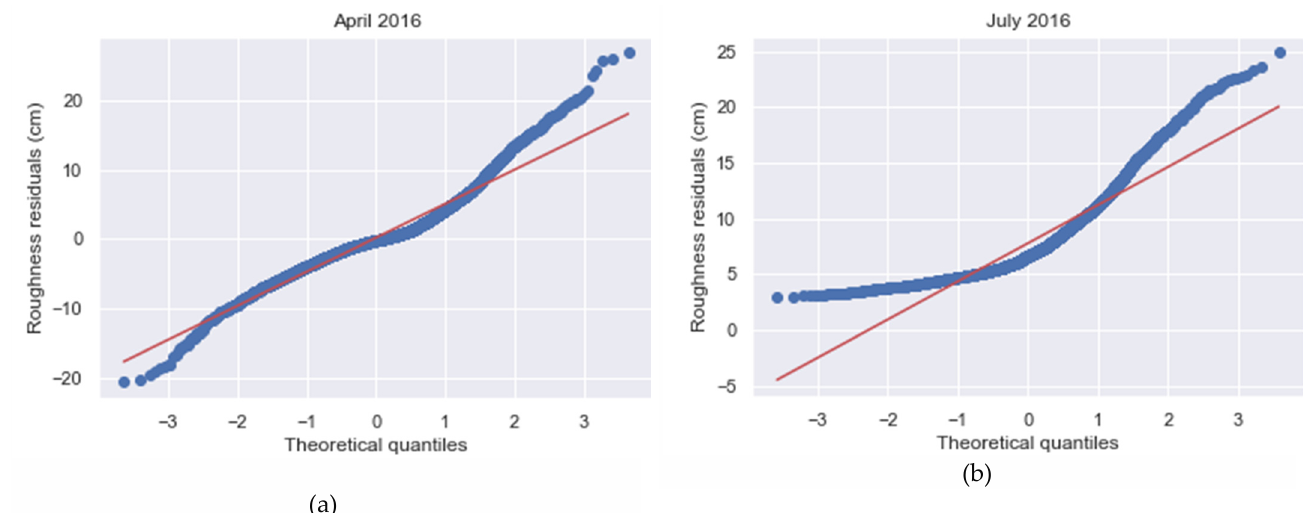
Figure 3. Q-Q plots for the April and July 2016 datasets ( a and b ) show the error distribution of MISR-estimated roughness for ( a ) April and ( b ) July 2016. estimated roughness for ( a ) April and ( b ) July